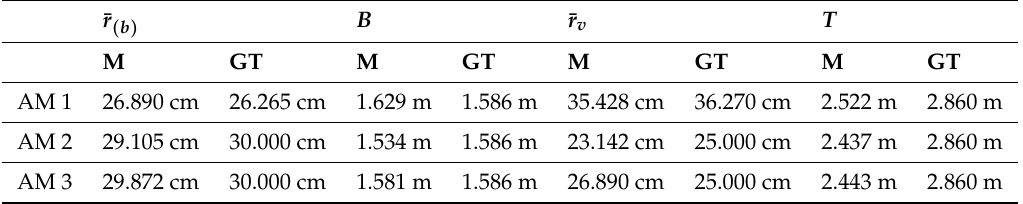
Table 2. Summarized results additional simulation results for Ackermann (AM) steering. AM 1 and AM 2 are based on the standard friction of 0.9 for dry concrete. For AM 3, we changed the friction coefficient to 0.45. The histograms for AM 1–AM 3 can be found in the Supplementary